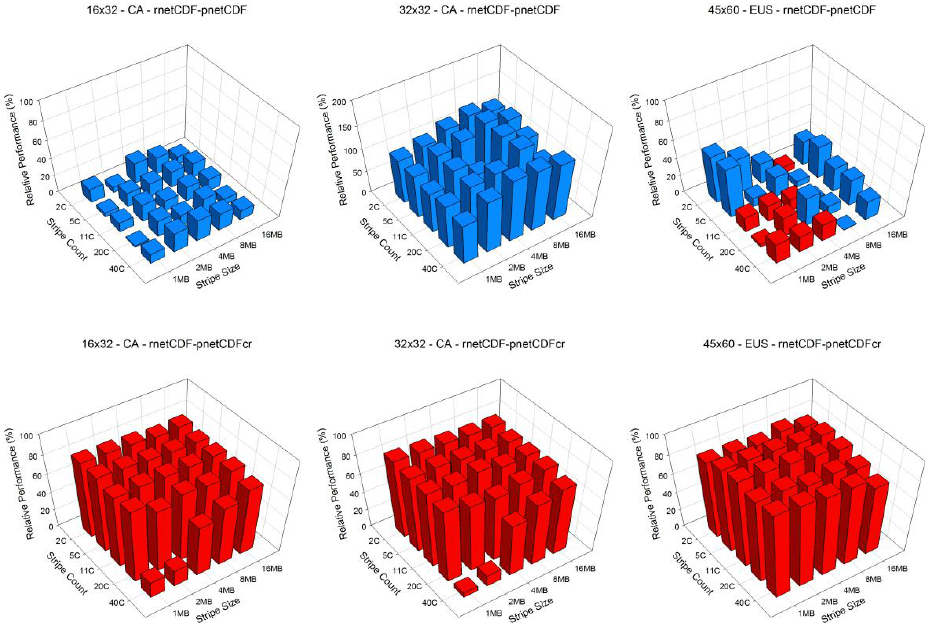
Figure 10. Relative performance of pnetCDF and pnetCDFcr with respect to rnetCDF in a large number of processors scenario on Kraken. Red color denotes positive value in relative performance while blue color denotes negative value in relative